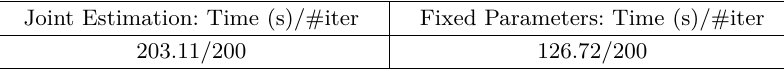
Table 5 Runtime comparison for self-tuning Huber RPCA (Joint Eestimation) v.s. single Huber RPCA with fixed ( κ, σ ) parameters. We fix number of iterations to be 200. Joint estimation takes less than 2 × run time for solving an RPCA problem with fixed